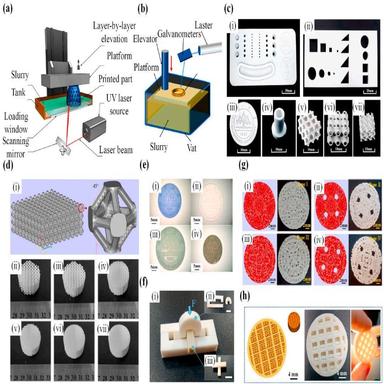
Classification of SLA technology: (a) Lifting, (b) Sinking and research advances in SLA technology: (c) ceramic parts prepared with 85 wt% solid-phase content of Al2O3, (d) Al2O3 ceramic filters with controllable porosity, (e) colored ZrO2 ceramic school emblems, (f) HAP samples for interfacial tensile strength testing and Al2O3 molds , (g) loofah-like hydroxyapatite bionic bone scaffolds, (h) PEGDA/nHAP porous scaffolds.